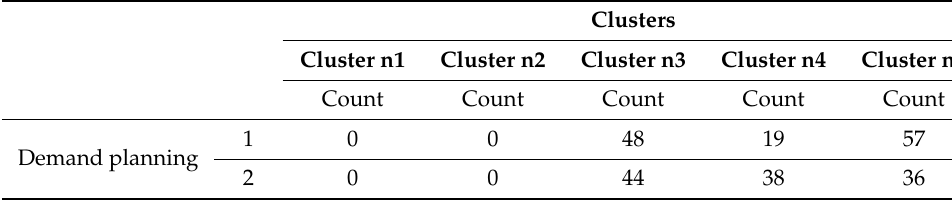
Table A1. The frequency of responses for each factor in the